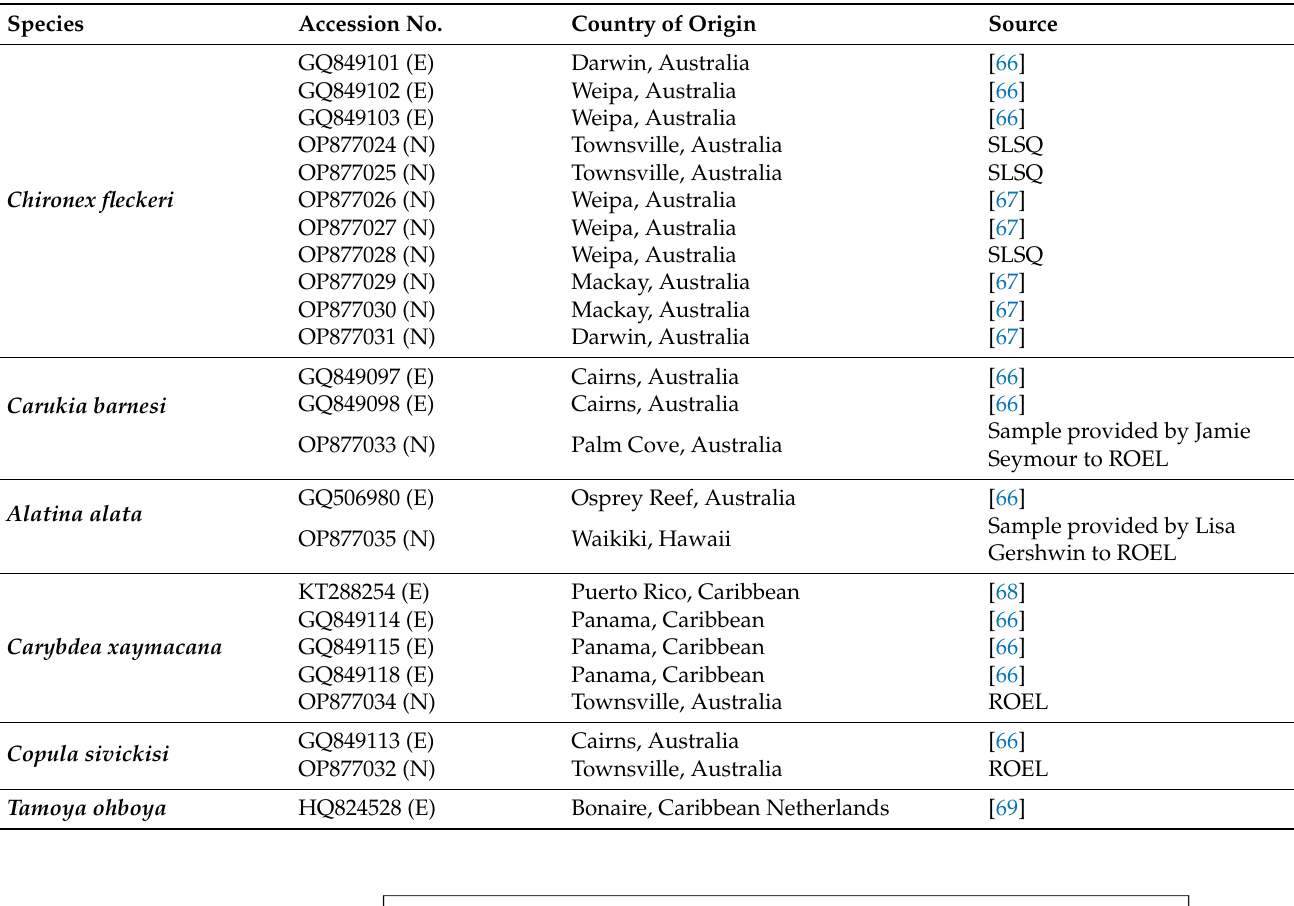
Table 1. Cubozoan sequence database utilised for assay design, with NCBI accession numbers and country of origin, for both existing (E) and new (N) 16S sequences (ROEL—Reef and Ocean Ecology Laboratory, SLSQ—Surf Life Saving Queensland).